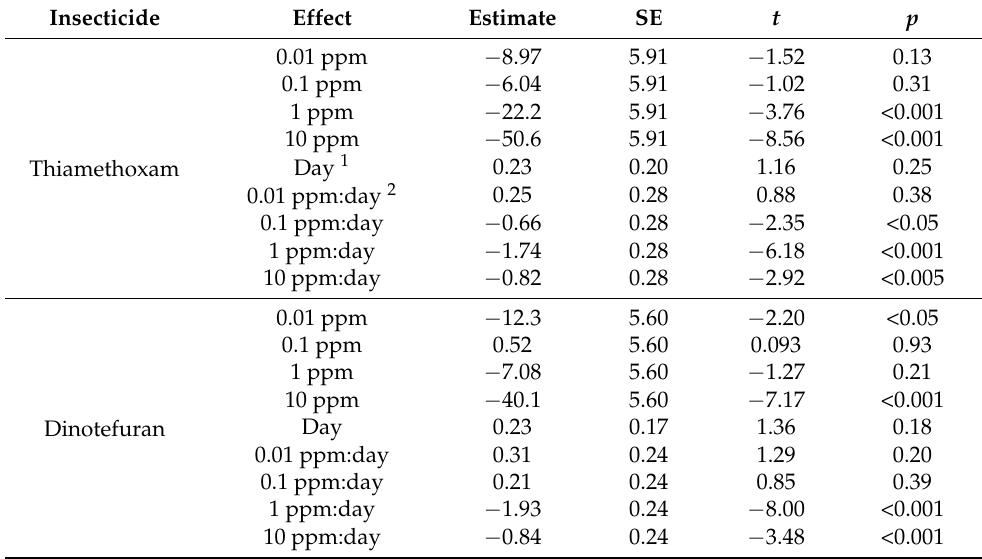
Table A1. Parameter estimates for GLMMs to explain the diet–boring rate by Aromia bungii neonates.